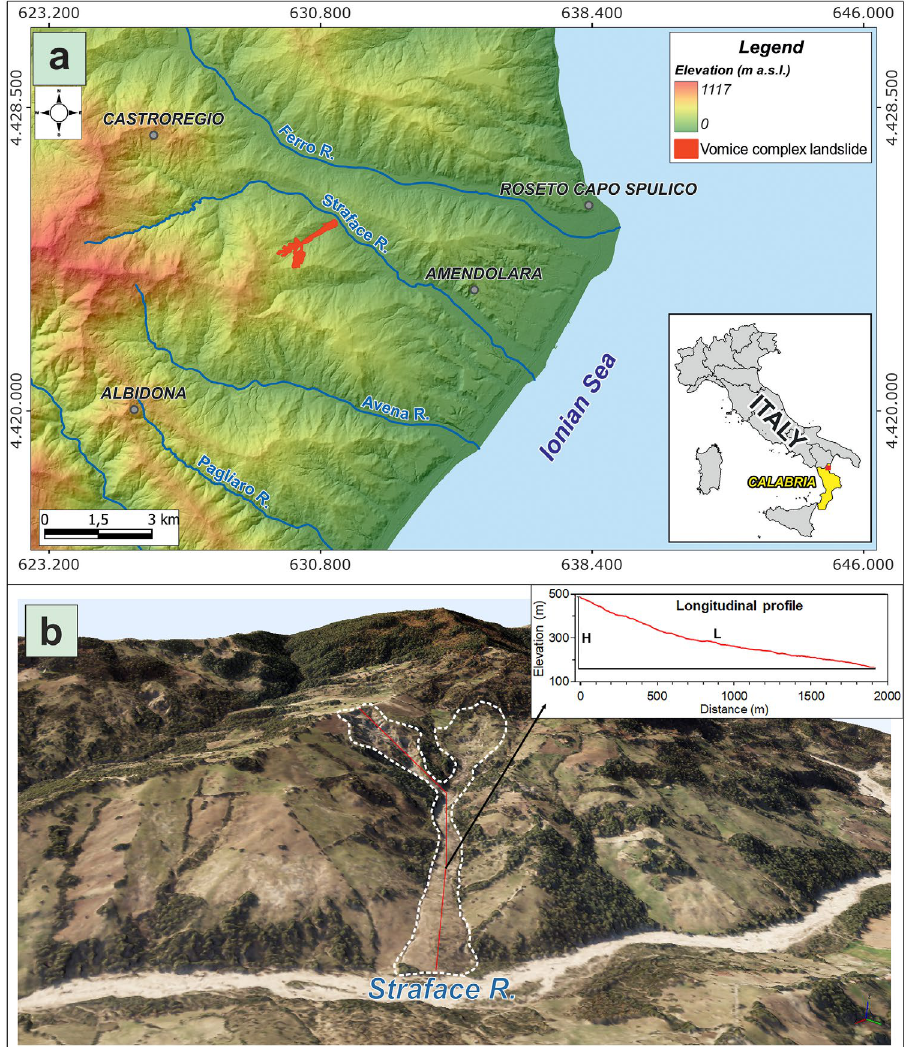
Figure 1. Location of the study area. ( a ) Geographical location of the study area (source data of DTM: http://geoportale.regione.calabria.it/opendata, accessed on 16 March 2016); ( b ) Google Earth satellite image of the Vomice earthflow dated 2019; a longitudinal profile extracted from DTM referring to 2022 is also shown.